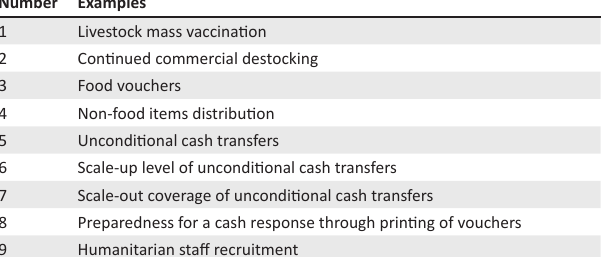
TABLE 2: Examples of activities not agreed to be no-regrets investments.